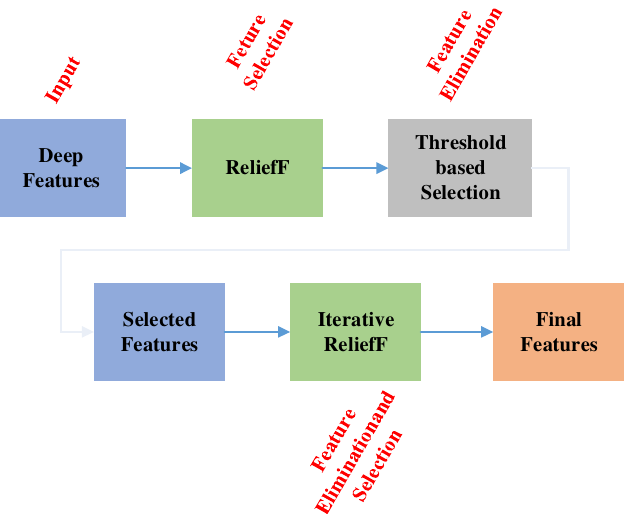
Figure 4. Snapshot of the presented TRFIRF model. In this model, ReliefF is applied two